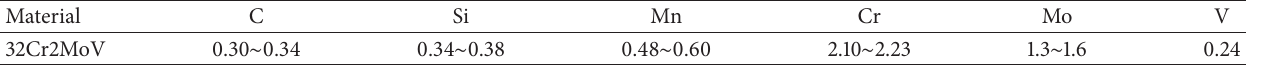
Table 1: The composition of 32Cr2MoV (Wt/%).